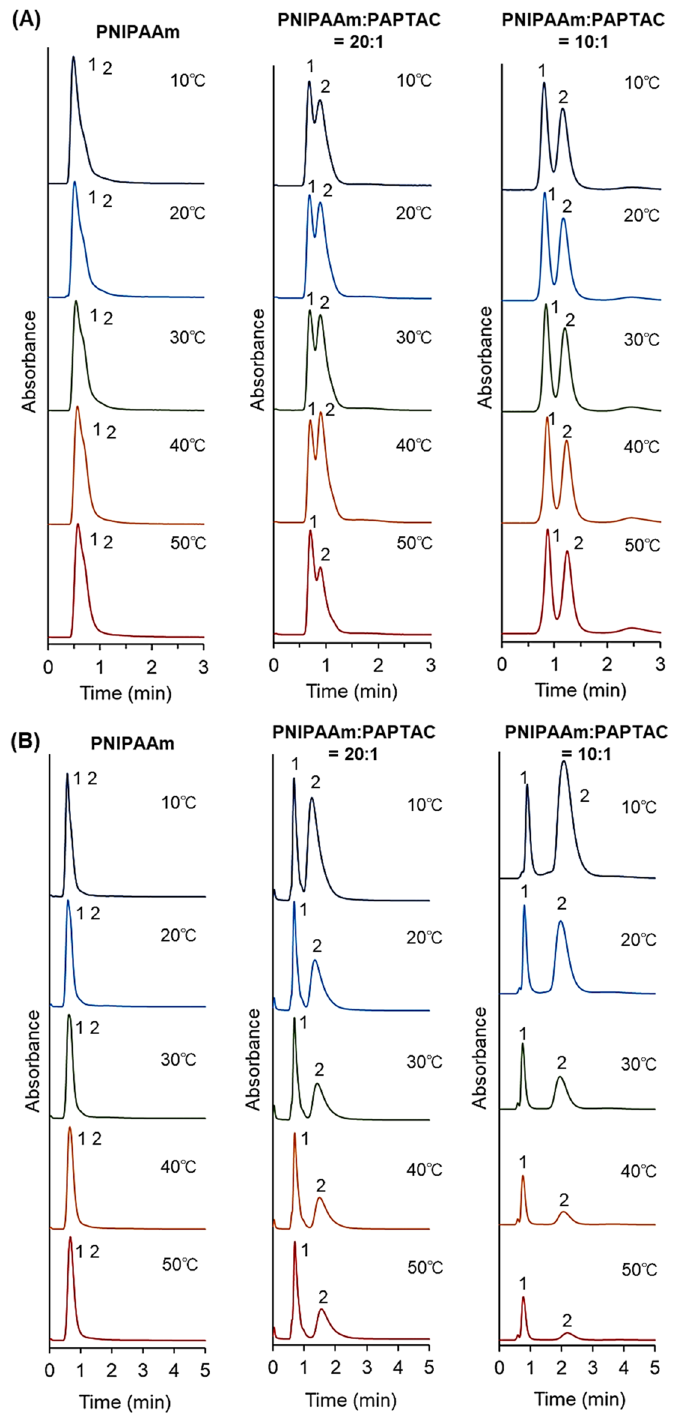
Figure 8. Chromatograms of oligonucleotides on prepared mixed-mode columns. ( A ) Mixture of d(T) 5 and d(T) 6 . The mobile phase is 66.7 mM phosphate buffer solution (pH = 7.0) with a flow rate of 1.0 mL/min. Detection was measured at a wavelength of 260 nm. Peak 1 = d(T) 5 and peak 2 = d(T) 6 . ( B ) Mixture of d(T) 5 and d(T) 10 . The mobile phase is 66.7 mM phosphate buffer solution (pH = 7.0) + 100 mM NaCl with a flow rate of 1.0 mL/min. Detection was measured at a wavelength of 260 nm. Peak 1 = d(T) 5 and peak 2 = d(T) 10 . (Figures were drawn Microsoft PowerPoint 2019 Version